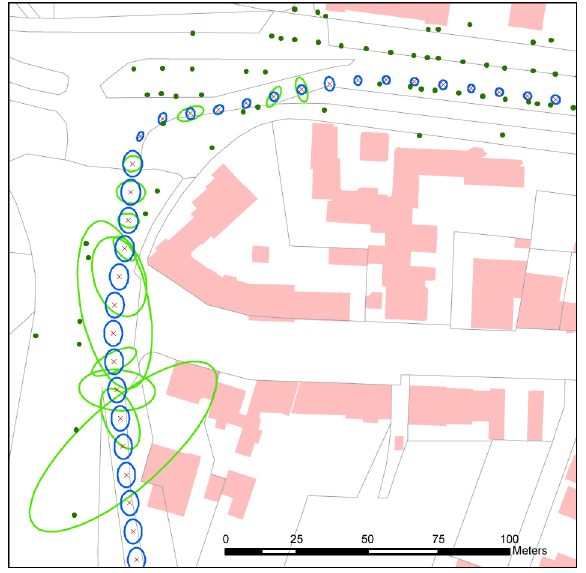
Figure 5. Positioning accuracy with filtered positions drawn as error ellipses for opening angle 100°, (blue: precise IMU, green: without IMU). All ellipses scaled by a factor of 20. (Upper right: green ellipses coincide with blue ellipses.)